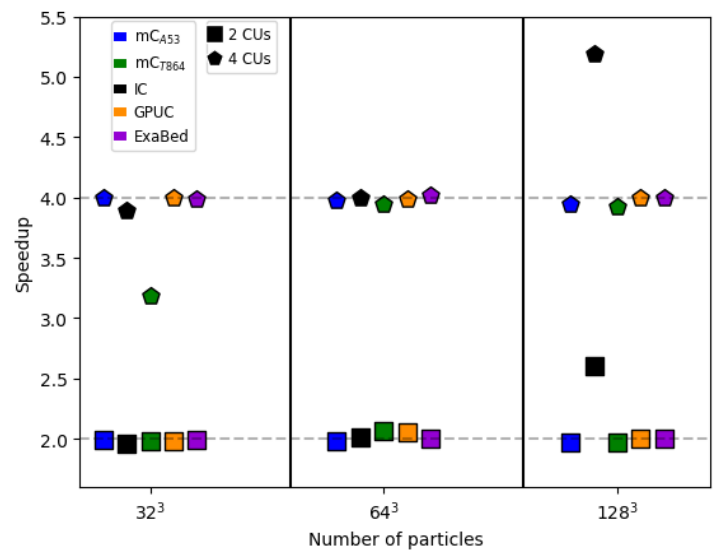
Figure 2. Speedup as a function of the number of particles using 2 and 4 CUs .